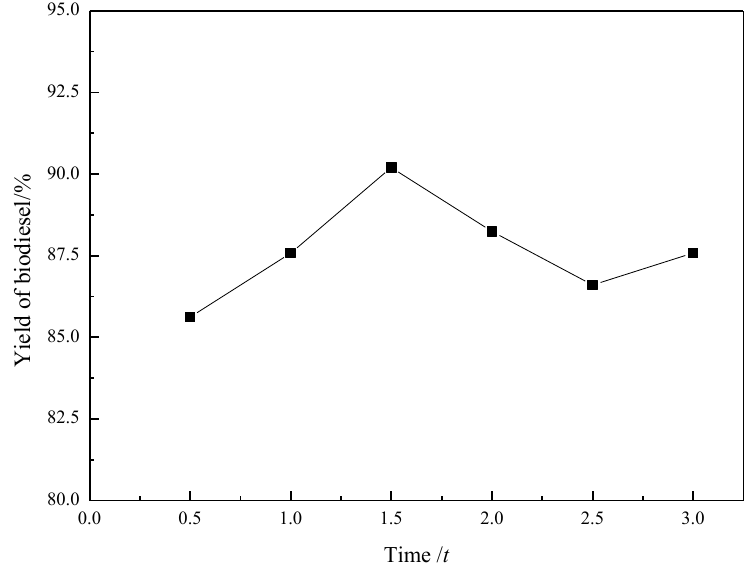
Figure 6. Effect of reaction time on the yield ( y ) in preparation of biodiesel catalyzed